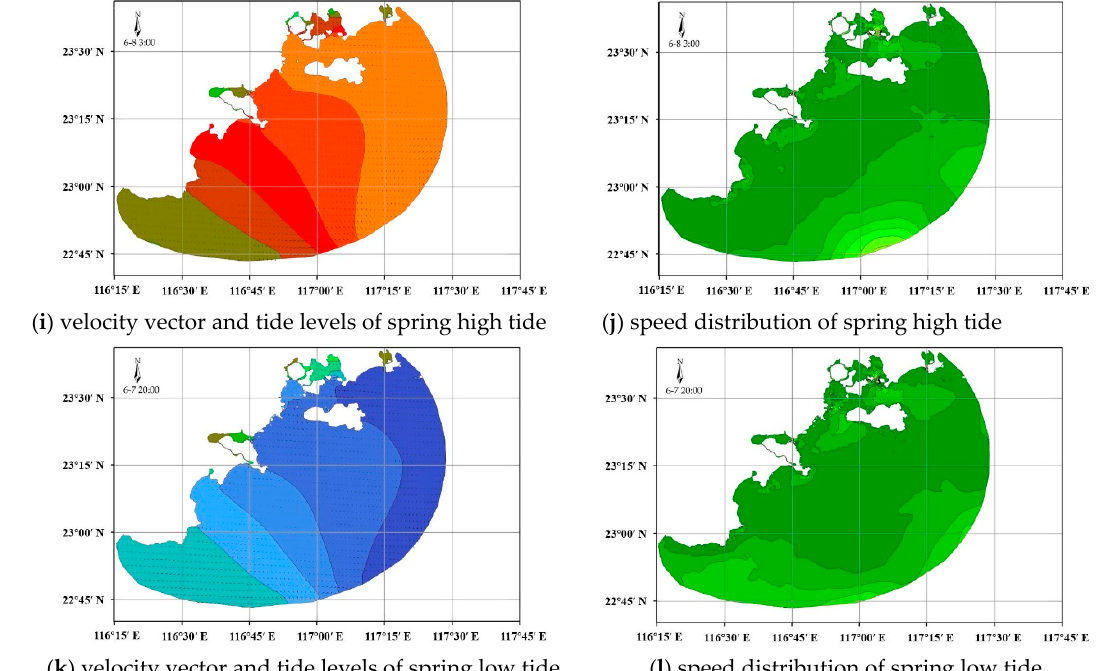
Figure 6. Distribution of tide levels and current speed in the study area.